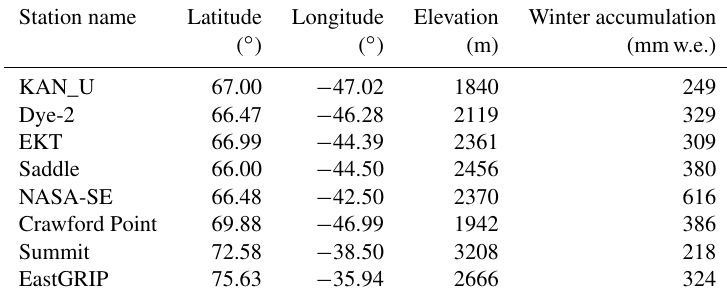
Table 1. FirnCover station locations and 2015–2017 average winter accumulation (Heilig et al., 2020).